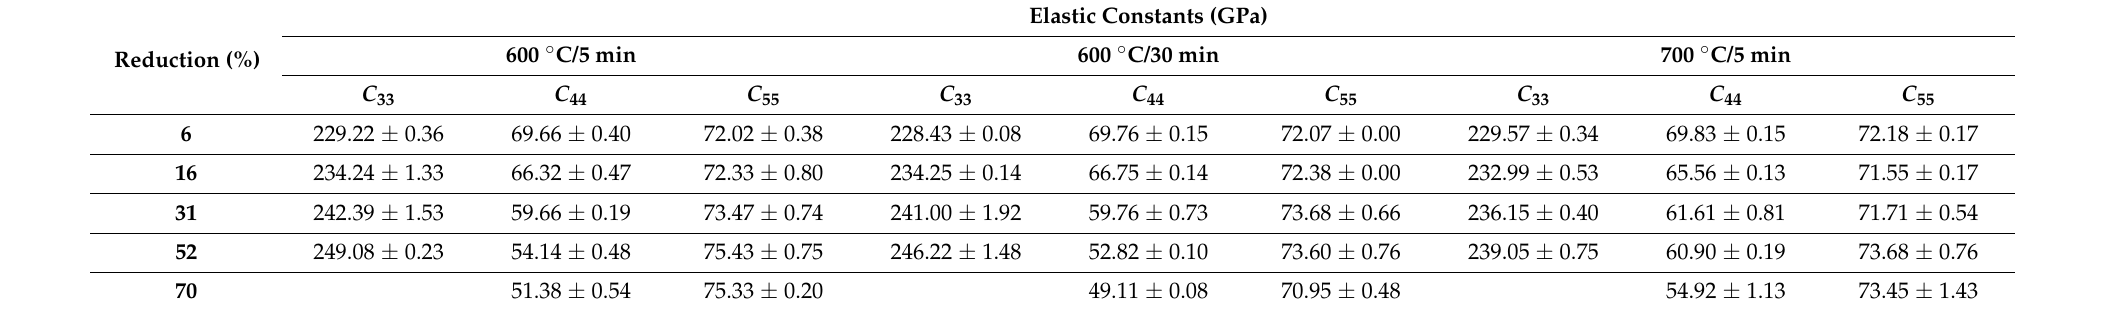
Table 6. Elastic constants after recrystallization annealing cold-rolled